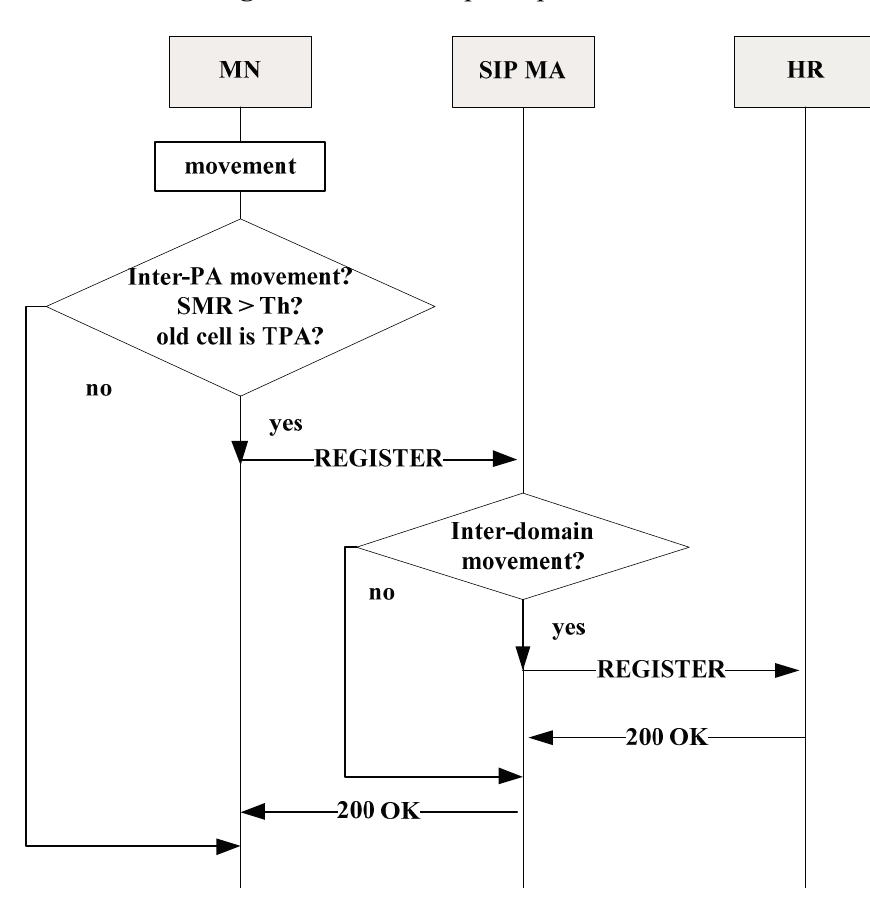
Figure 6. Location update